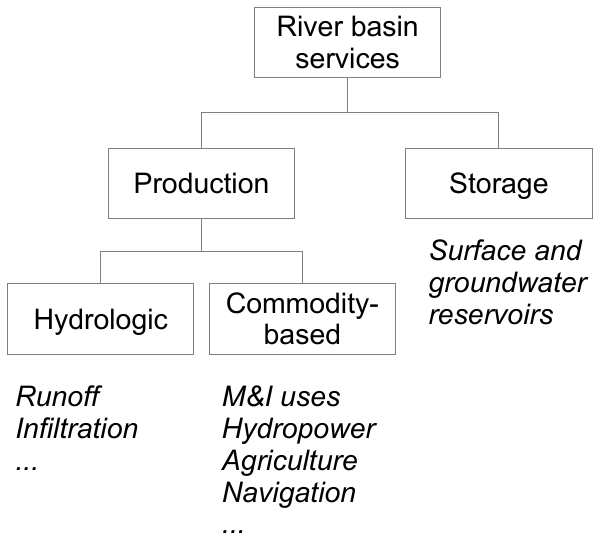
Figure 1. Production and storage services in a river